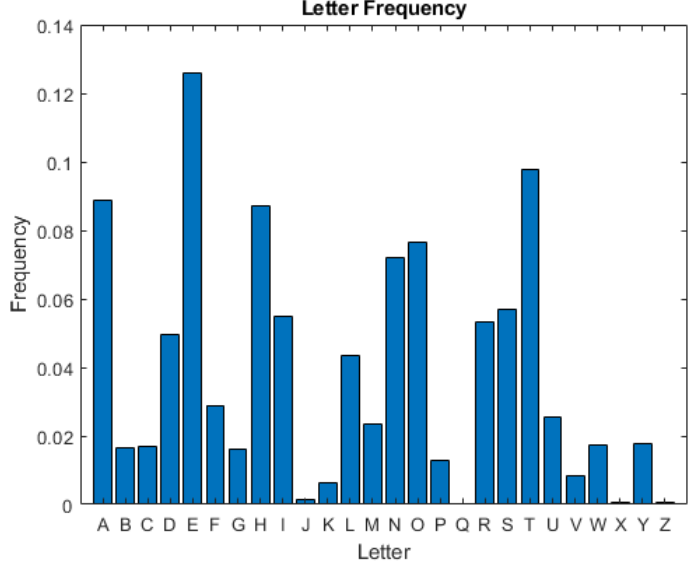
Figure 4. Frequency of plaintext.